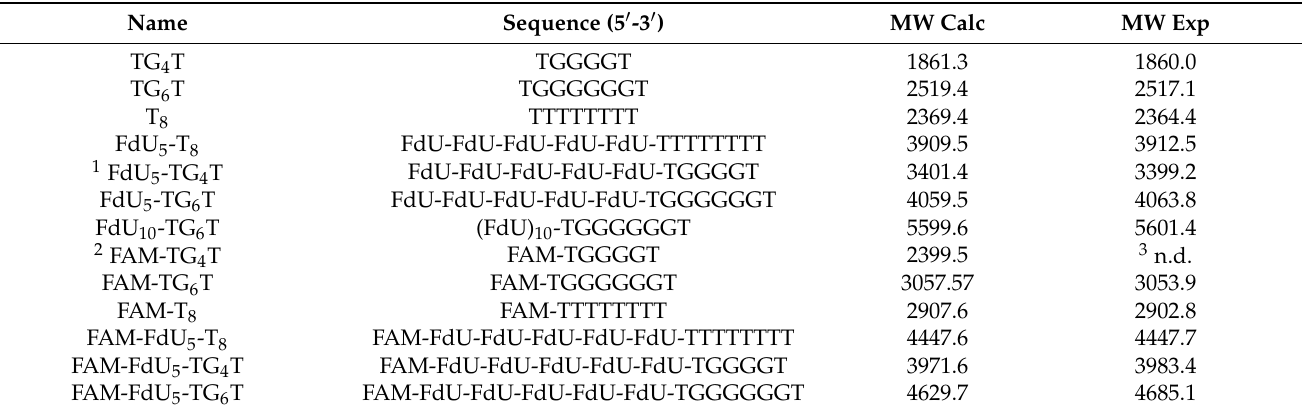
Table 1. Sequence and mass spectra of the DNA-